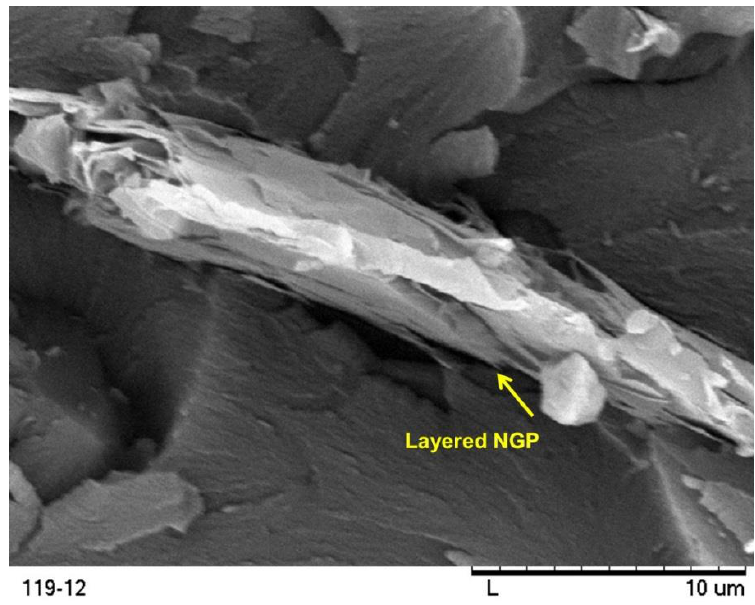
Figure 8. Enlarged view of nanocomposite fracture surfaces showing graphene morphology.